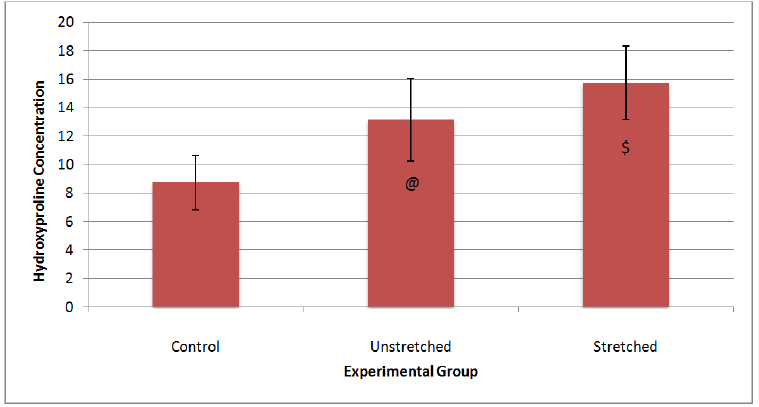
Figure 10. Hydroxyproline deposition normalized to DNA (ngHYP/ngDNA). n = 5. @, Statistically different than control ( p < 0.05); $, Statistically different than control ( p <